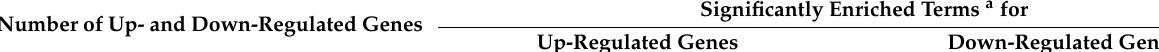
Table 2. Overview on the significantly enriched FunCat, GO, and KEGG pathway terms.